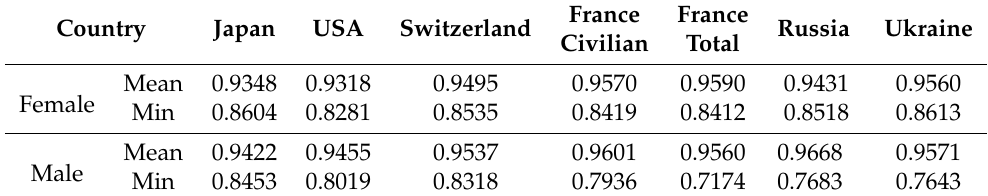
Table 8. R 2 w of the Heligman–Pollard model fitting